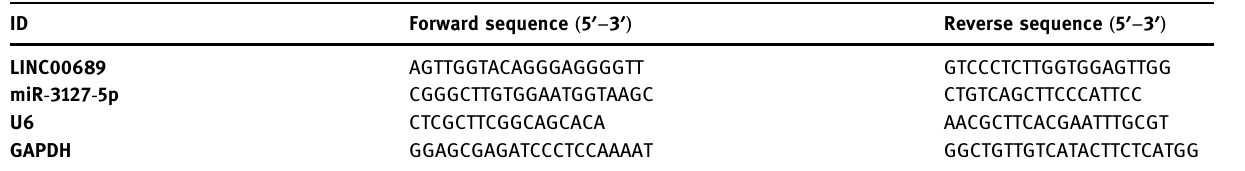
Table 1: All primers in qRT - PCR experiments in this study ID